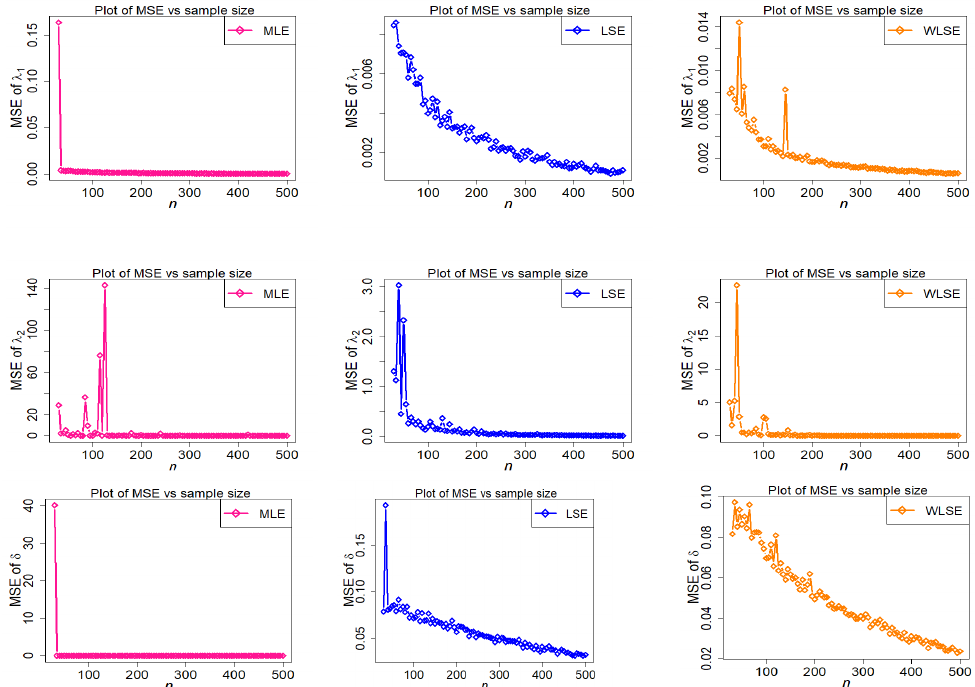
Fig. 12. Behaviour of MSE of estimators with di⁄erent methods under parametric set II